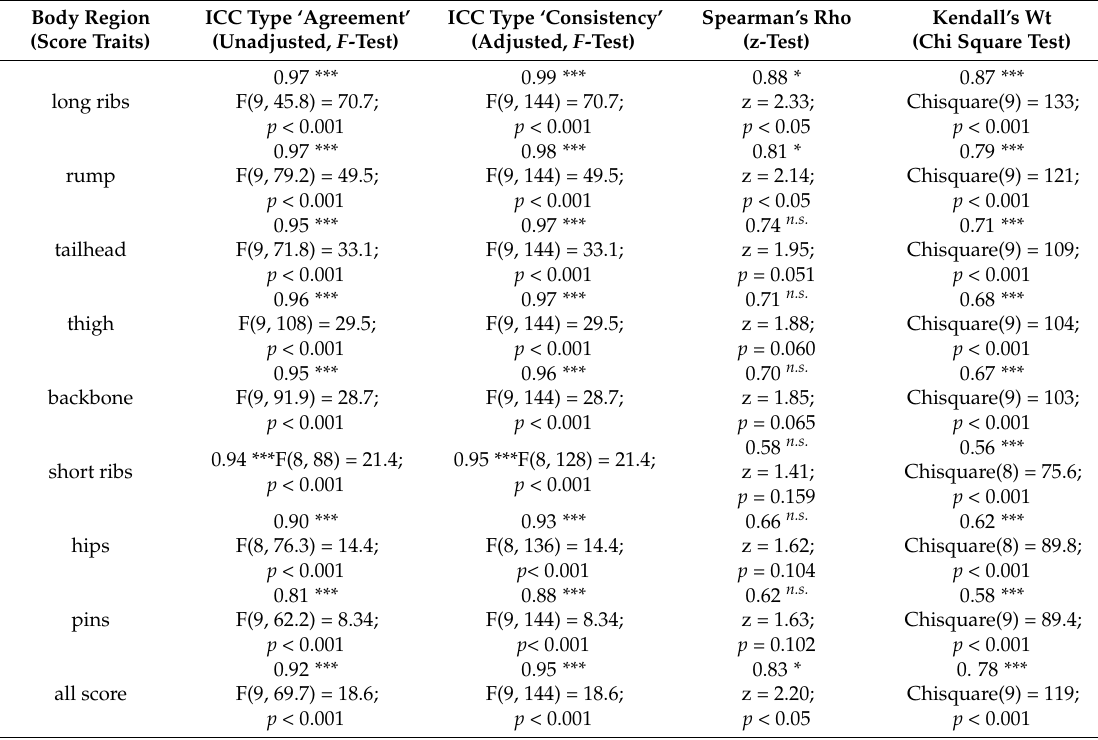
Table 1. Assessors’ agreement in scoring different body regions. Intraclass correlation coefficients (ICC), mean of bivariate Spearman’s rho rank correlations (Rho), and Kendall’s coefficient of concordance (Wt) were used as indices of inter assessors’